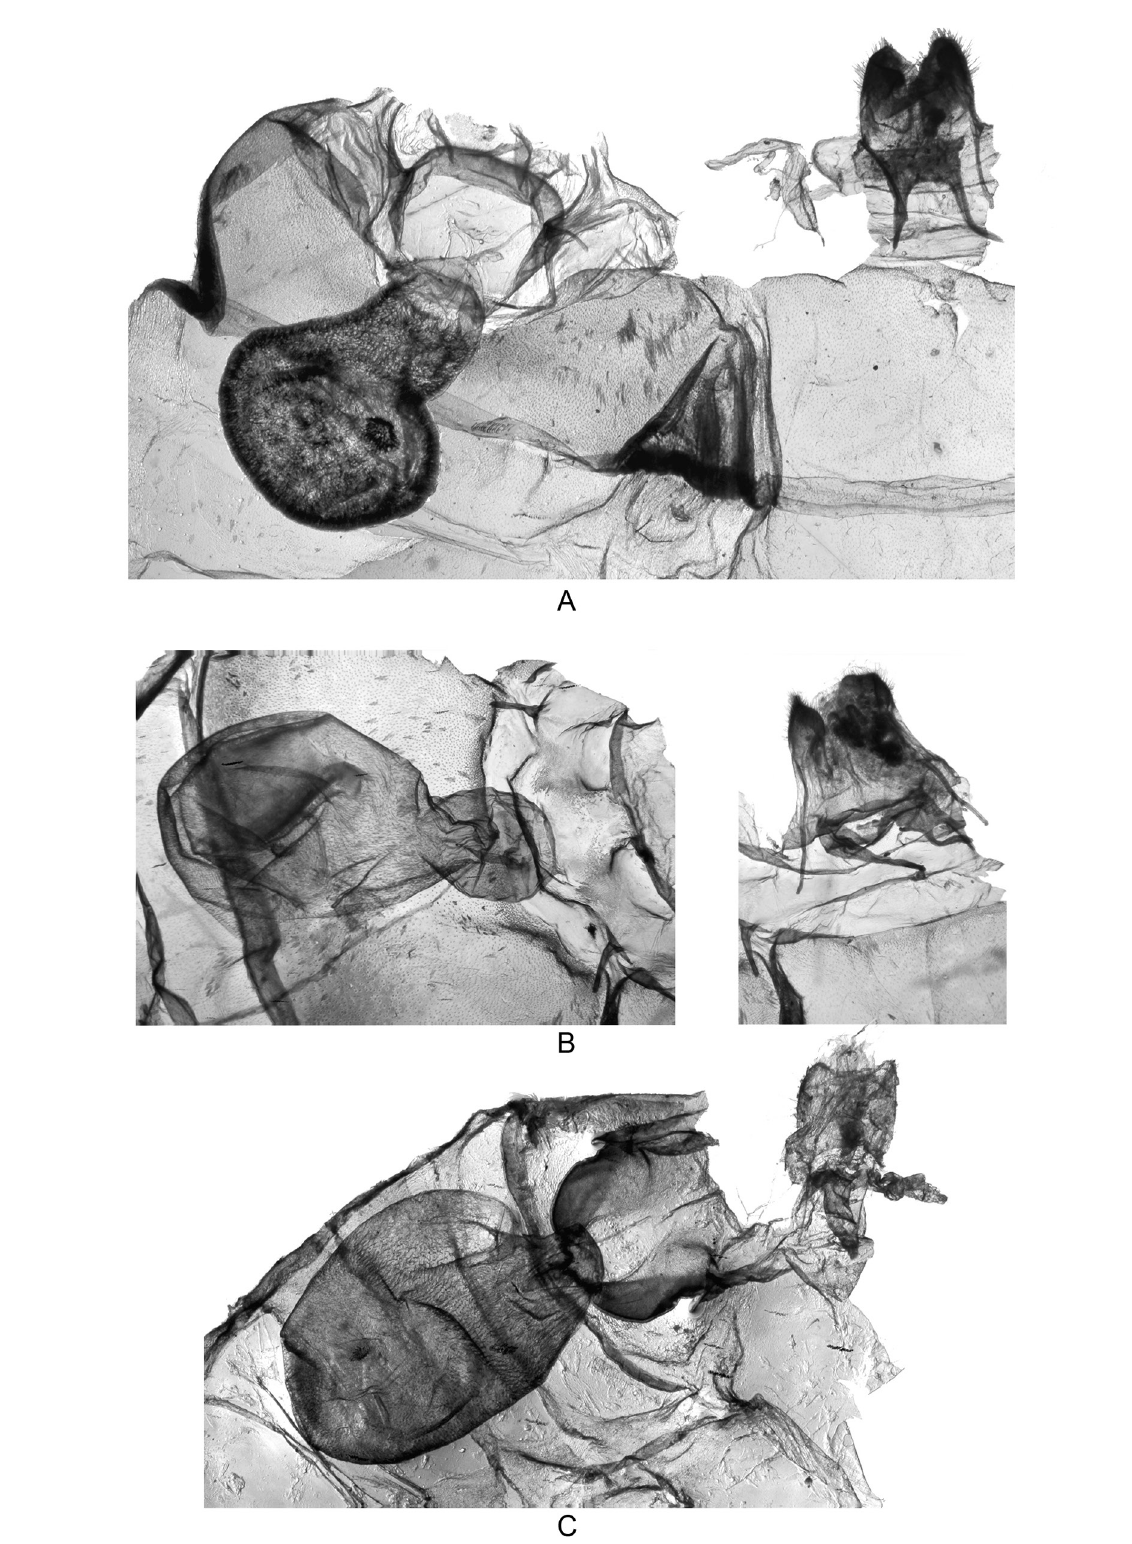
Fig. 5. Female genitalia. Figures are not in equal proportion. A . Nanna ceratopygia Birket-Smith, 1965, ♀ allotype. B . Nanna eningae (Plötz, 1880), ♀, Gabon, Makokou-Ipassa, 500 m, 0°30’43’’N 12°48’13’’E, 5-10 Apr. 2010, gen. prep. n. 558/10 MAD. C . Nanna semigrisea sp. nov., ♀